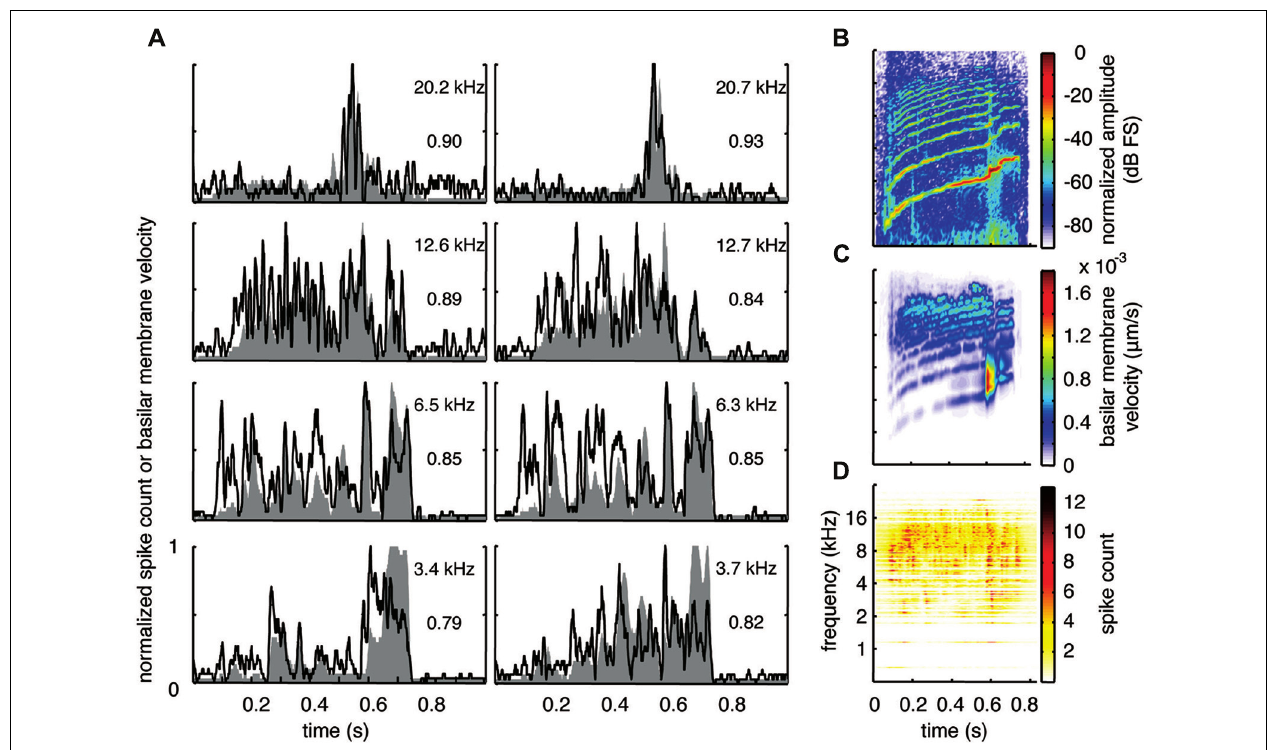
FIGURE 6 | Spectrotemporal representation forTSV. Neural activity was recorded across a wide range of best frequency regions from 10 animals and compared to the corresponding frequency-specific DRNL outputs of the stimulus. (A) DRNL outputs and PSTHs for four different frequency laminae (shown in rows) corresponding to two different shanks (shown in columns) from the same recording probe. Black lines correspond to the PSTHs and gray shaded areas correspond to the DRNL outputs.The best frequency and the peak correlation value for each recording site are labeled on the top-right of each plot. (B) Spectrogram of the stimulus using the short-time Fourier